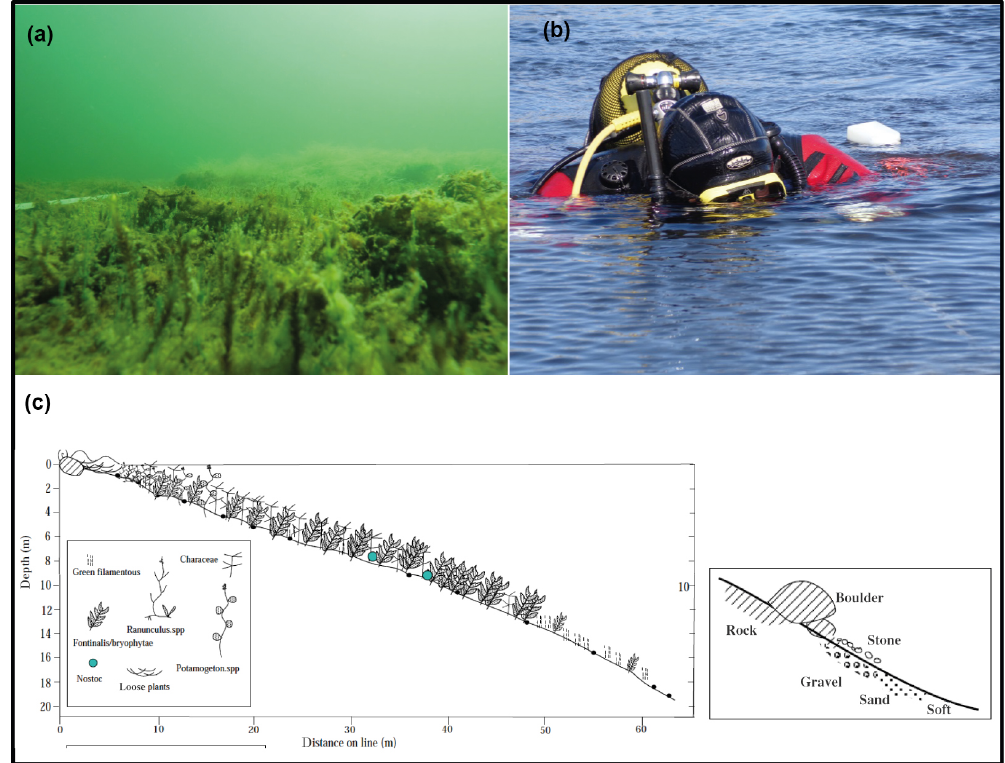
Figure 8. Photos from the macrophyte inventory (a, b) and sketches from the resulting inventory transect (c) .